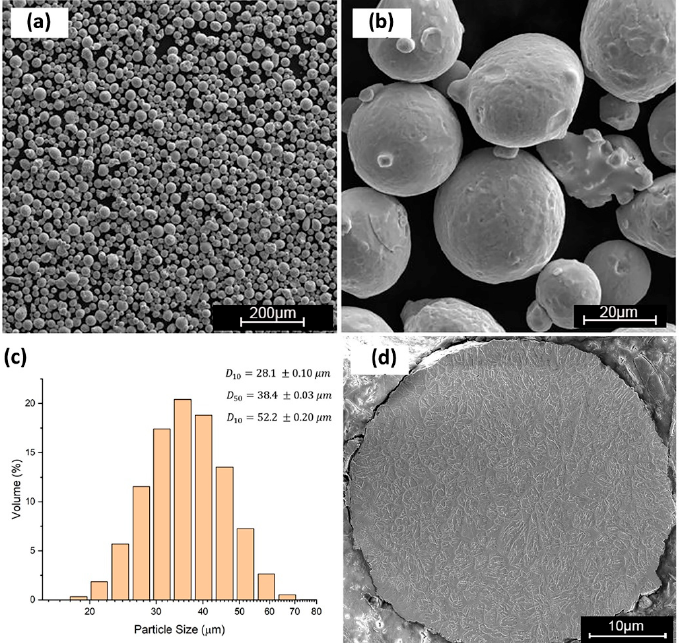
Figure 1. Characteristics of H13 powder: ( a , b ) Powder morphology; ( c ) particle size distribution (PSD) analysis; and ( d ) cross-section of the powder particle.